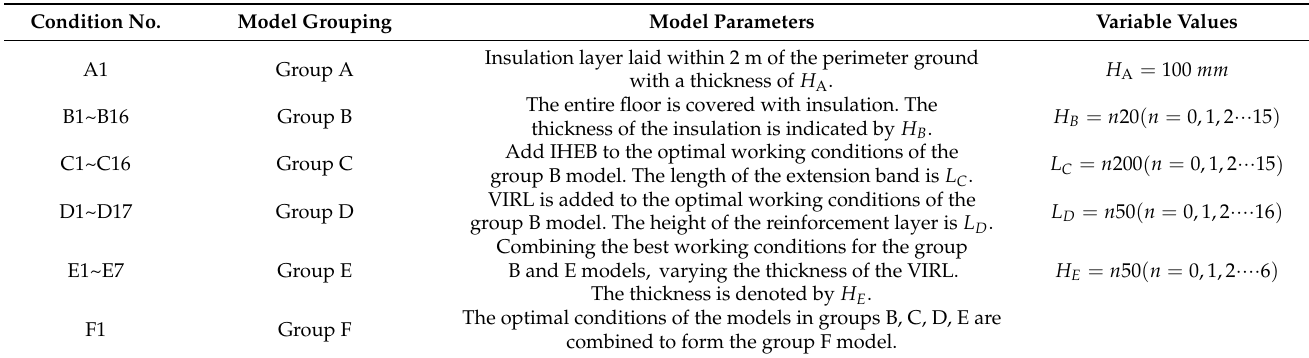
Table 1. Working conditions’ settings and simulation parameters.